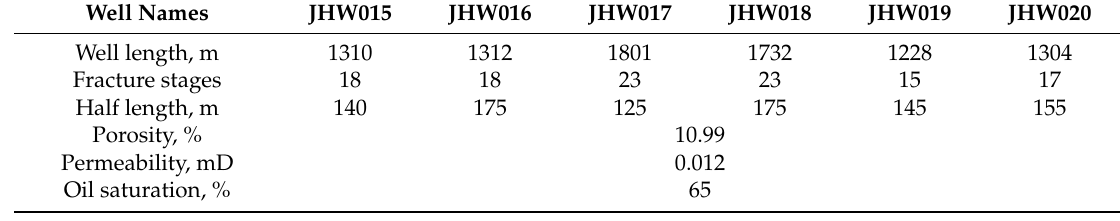
Table 2. Some fracturing parameters for the well-industry-production-scheme.